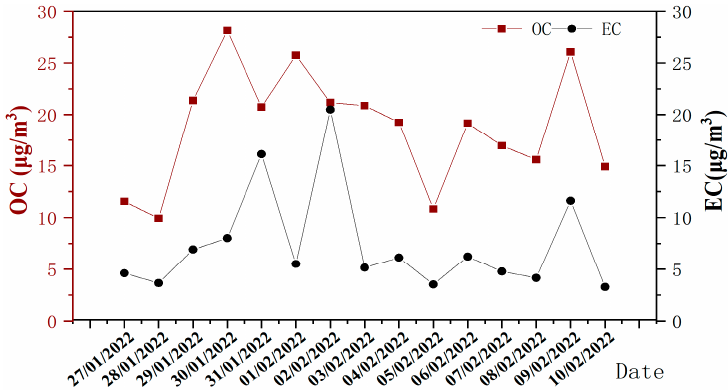
Figure 2. Distribution of OC and EC in PM 2.5 during the sampling period.